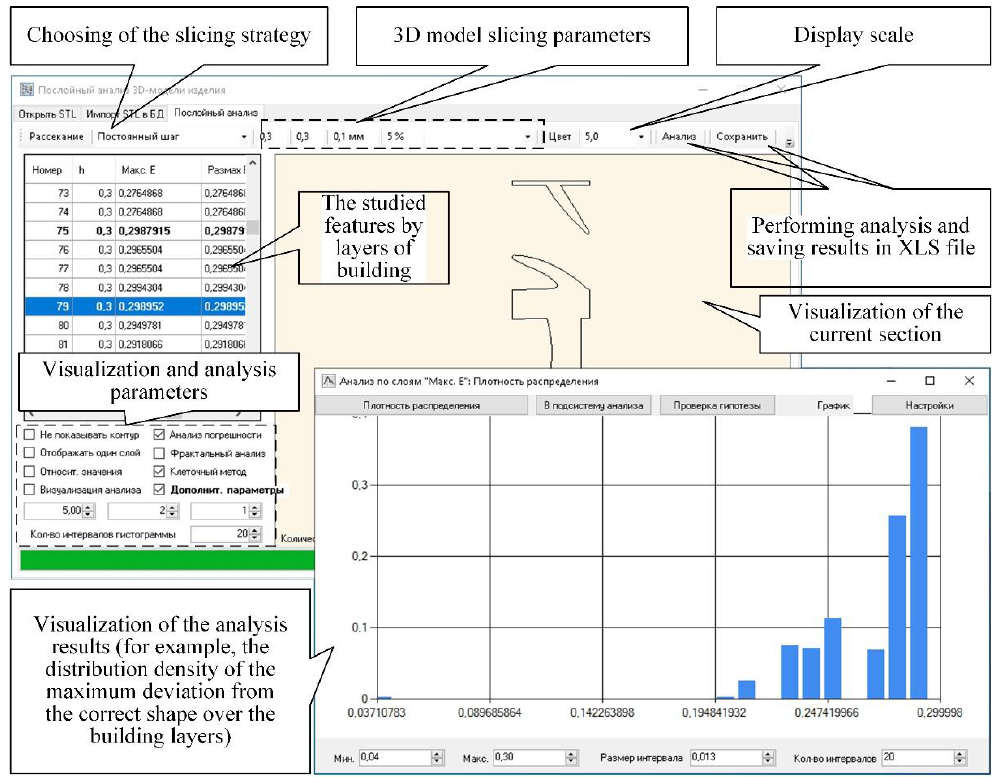
Figure 1. Subsystem layered analysis of 3D model.